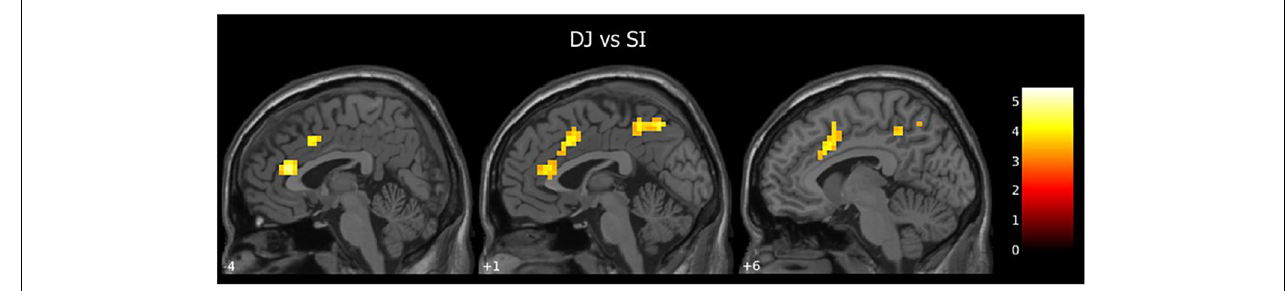
TABLE 4 | Significant areas of activation for the comparison “SI vs. baseline” (cluster size threshold k ≥ 23, corrected at α < 0.05). Side Cluster Voxel level MNI Coordinates Brain areas BA K T x y z Inferior frontal gyrus 47 L